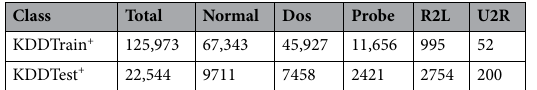
Table 1. Label classification in NSL-KDD